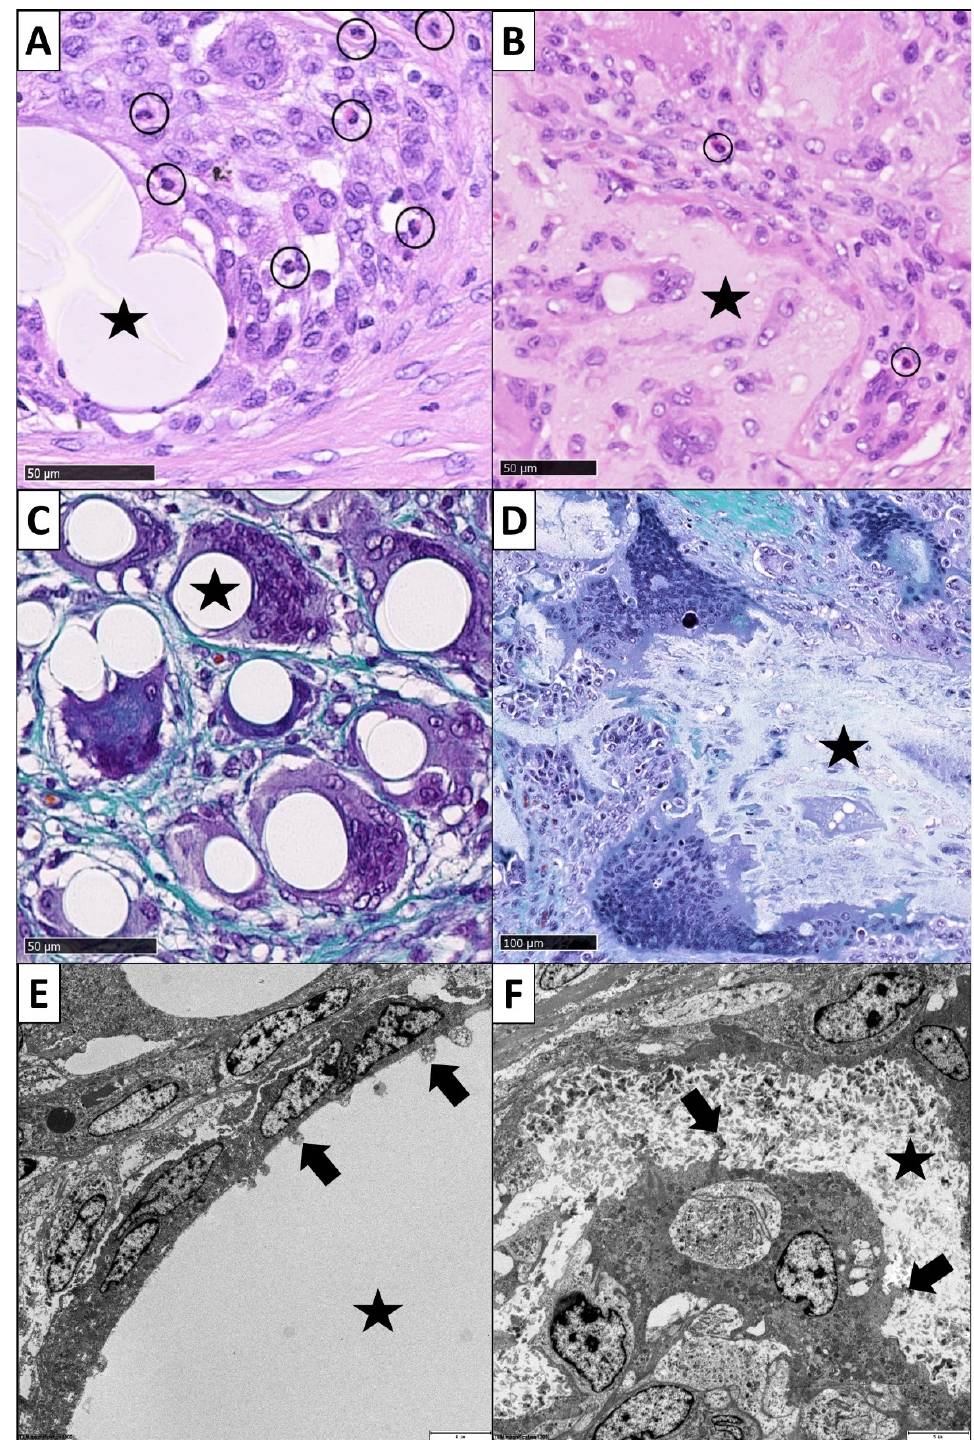
Figure 3. Histopathological analysis of PMNs (black circles) on ( A ) a filamentous biomaterial (star) and ( B ) the sponge-like biomaterial (star). The PMNs clearly show characteristic segmented nuclei (H&E staining, 400× magnification). ( C ) FBGCs in interaction with a filamentous design (star): FBGCs are located in close proximity of the fibers. FBGC shape reminds of an embracement of the fibers (Masson-Goldner trichrome staining, magnification ×400). ( D ) FBGCs in interaction with the sponge-like biomaterial (star): FBGCs can take on gigantic dimensions, show heterogeneous cell shapes and multiple nuclei distributed in the cytoplasm (Masson-Goldner trichrome staining, magnification ×200). ( E ) Ultrastructural TEM image of the interface of FBGC and a filament (star):